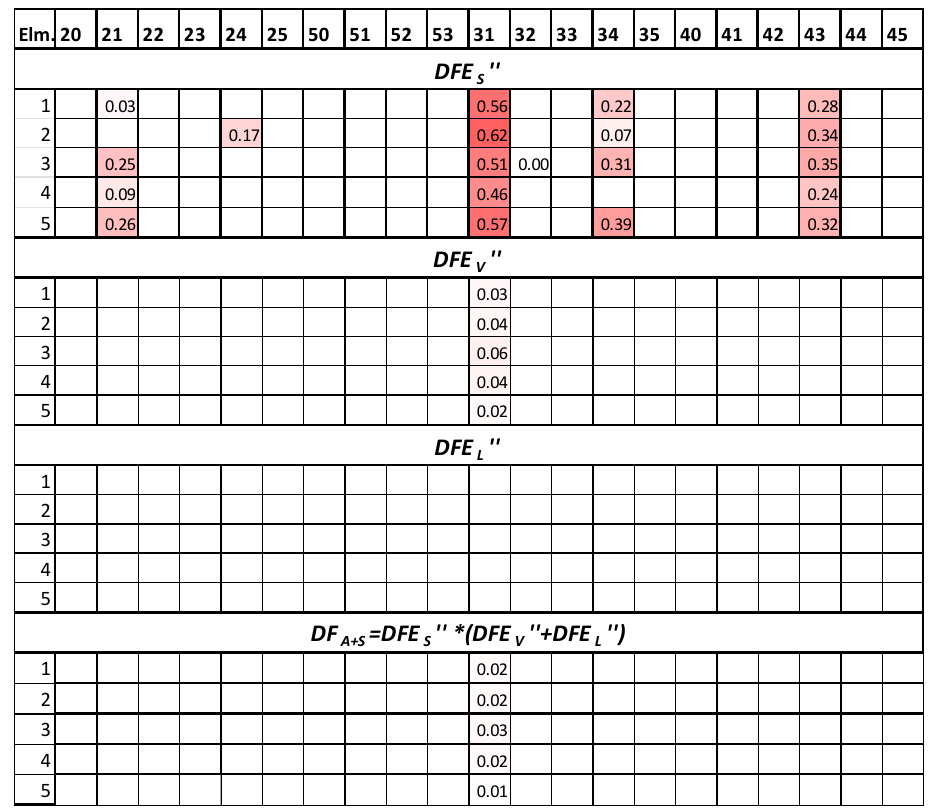
Figure 7. The actual location of damage for damage case-1.